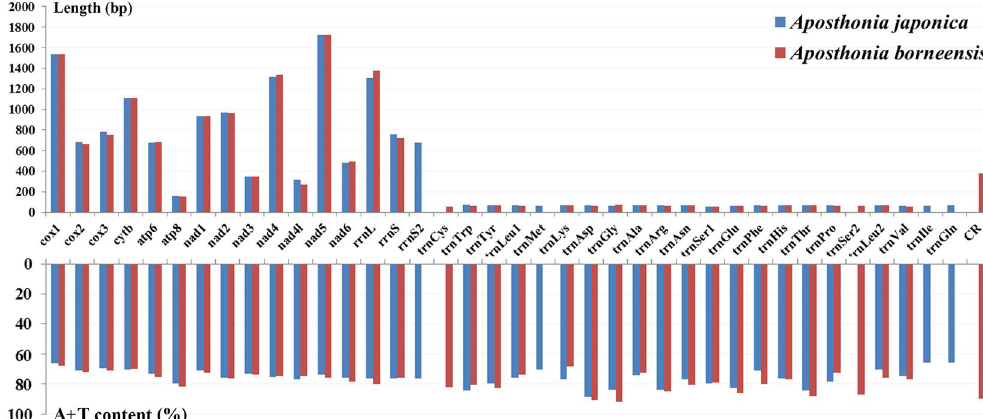
Figure 2. Gene size and A + T content of genes in the two webspinner mitogenomes. A. japonica and A. borneensis are represented by blue and red columns, respectively. Gene names are shown on the X axis; gene sizes and A + T content are shown on Y axis.